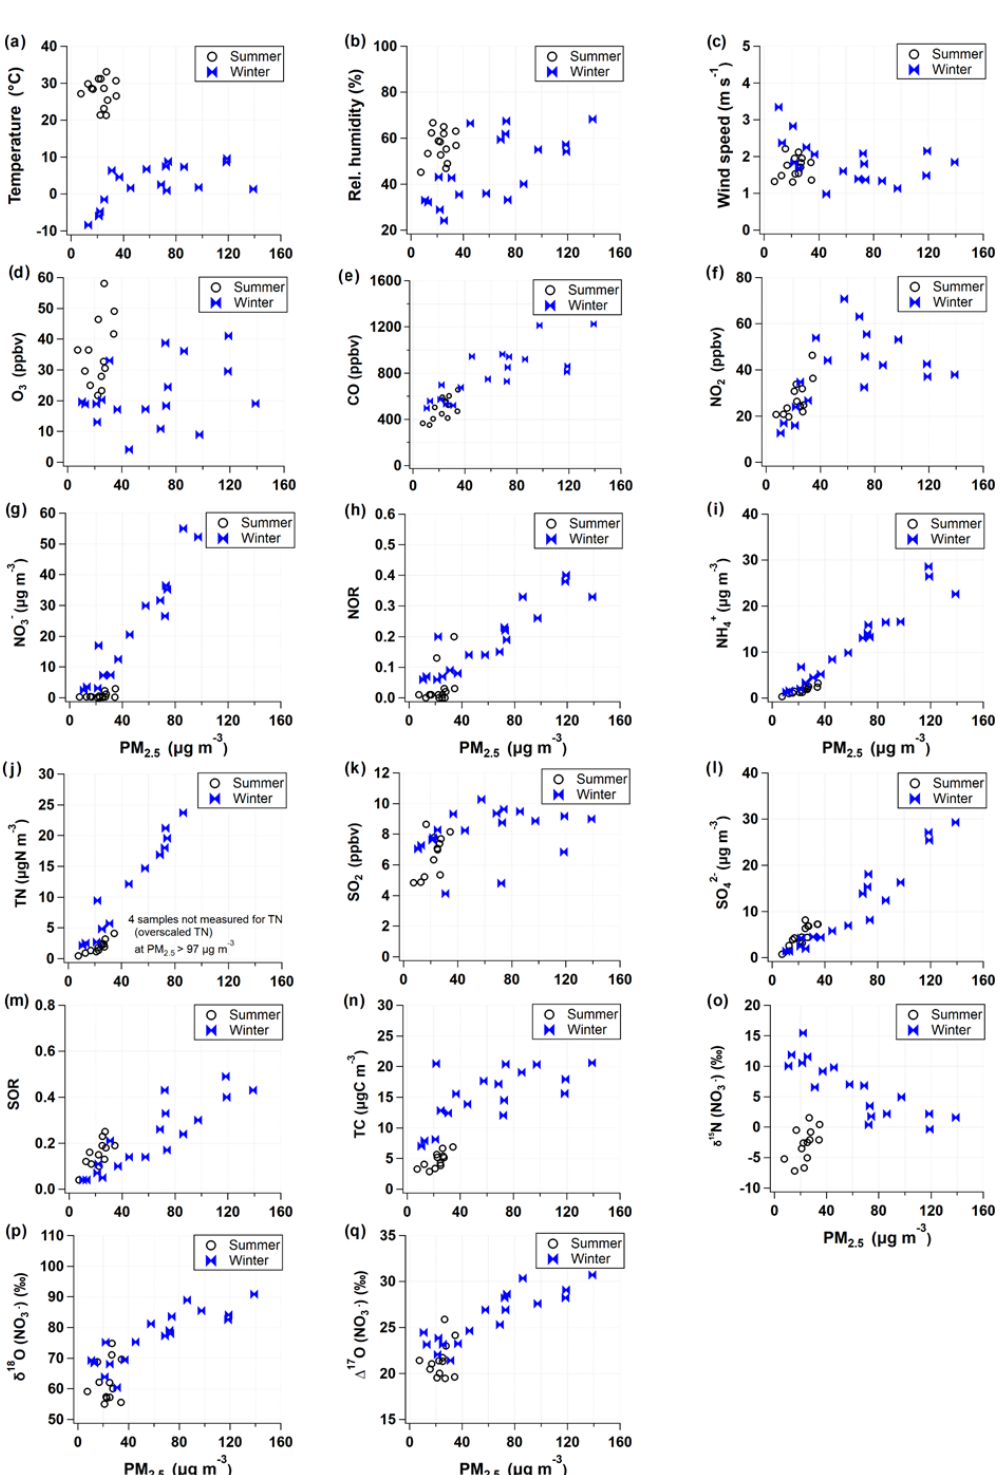
Figure 3. Relationships of PM 2 . 5 mass concentration with meteorological parameters (a–c) , concentrations of reactive gases (d–f, k) and aerosol chemical constituents (g–j, l–n) , and N and O isotopic compositions (o–q) measured in Seoul during the summer (open circle) and the winter (blue